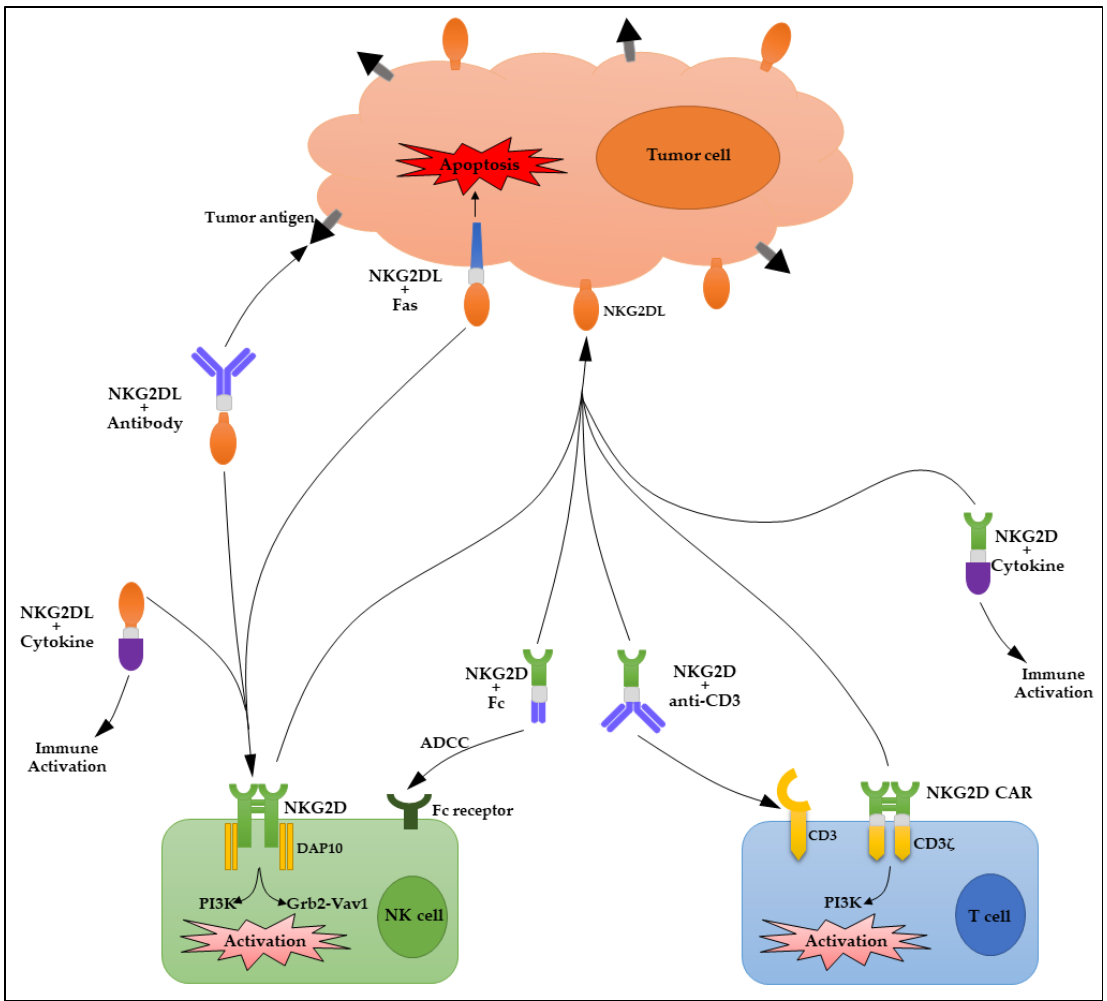
Figure 1. Schematic diagram of fusion proteins of NKG2D (natural killer group 2, member D)/NKG2D ligands (NKG2DLs) in cancer immunotherapy. Fc, fragment crystallizable region of an antibody; ADCC, antibody-dependent cell-mediated cytotoxicity; CD3, cluster of differentiation 3; DAP10, hematopoietic cell signal transducer; PI3K, phosphatidylinositol-3 kinase; Grb2, growth factor receptor-bound protein 2; Vav1, vav guanine nucleotide exchange factor 1; CAR, chimeric antigen receptors.